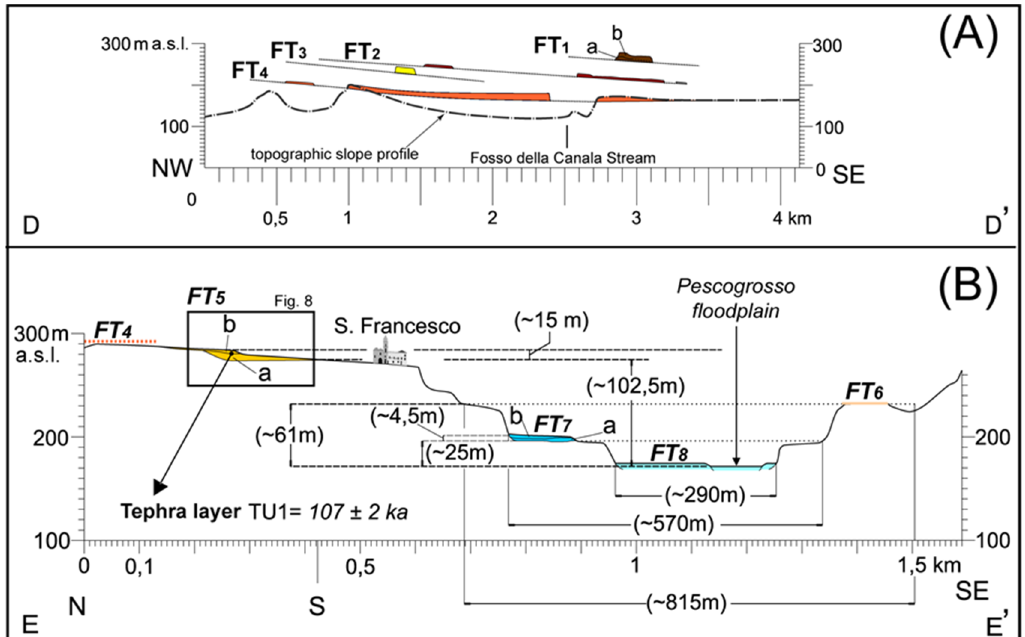
Figure 12. Plot of fluvial terraces against the topographic slope profile of the Cugno Longo hanging valley ( A ). Transverse topographic profile of the Pescogrosso Stream valley and location of the fluvial terraces ( B ). See Figure 3 for location of the trace profile.